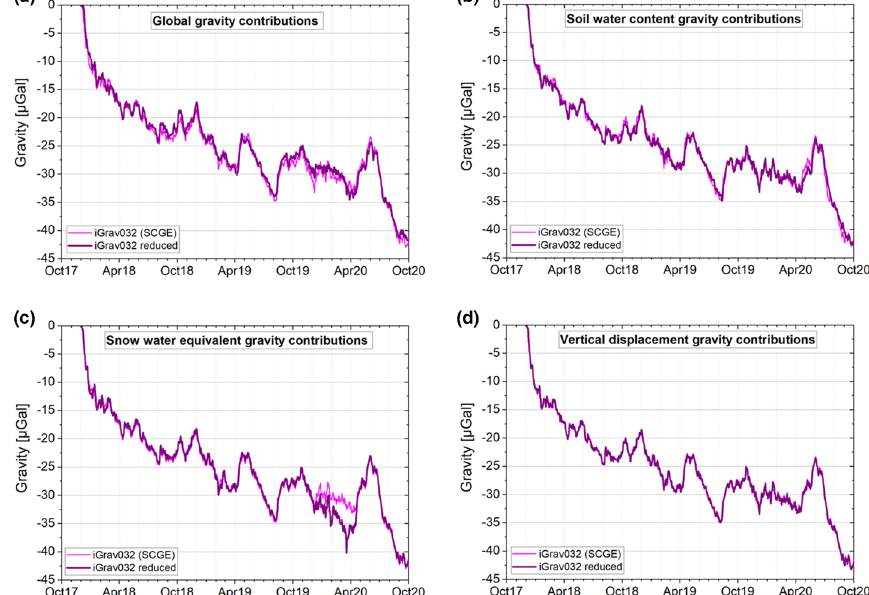
Fig. 19 Reductions of environmental gravity contributions for iGrav032 (SCGE, 3 years observation period) for a global gravity contributions; b soil water content variations; c snow water equivalent, and d vertical surface